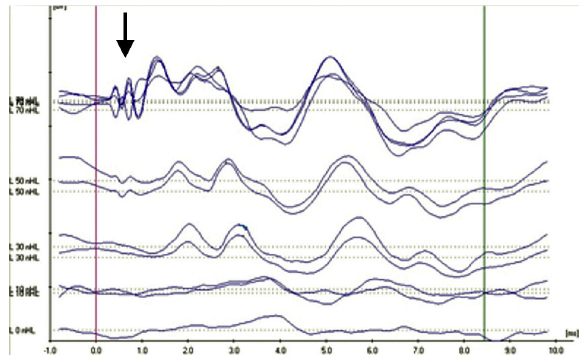
Example for Category 4 (the broken wave morphol- ogy including the 2nd wave Cochlear